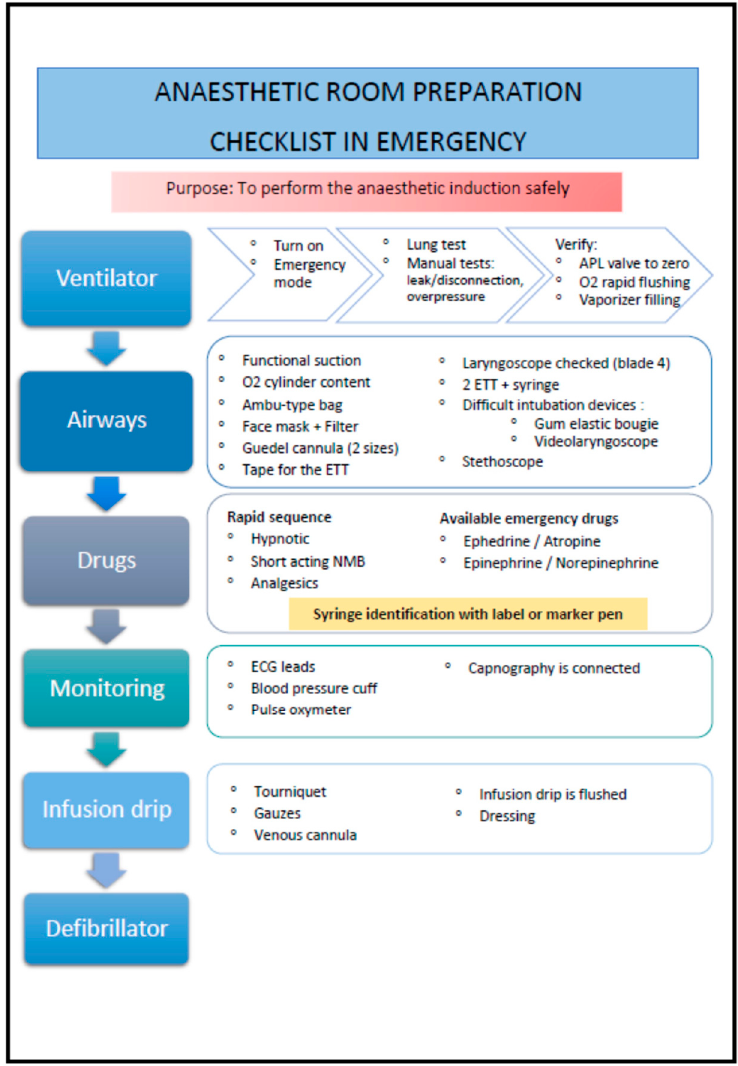
Figure 1. English translation of the cognitive aid given to the anesthesia residents. ECG, electrocar- diogram; ETT, endotracheal tube; APL, adjustable pressure-limiting; NMB, neuromuscular blocker.